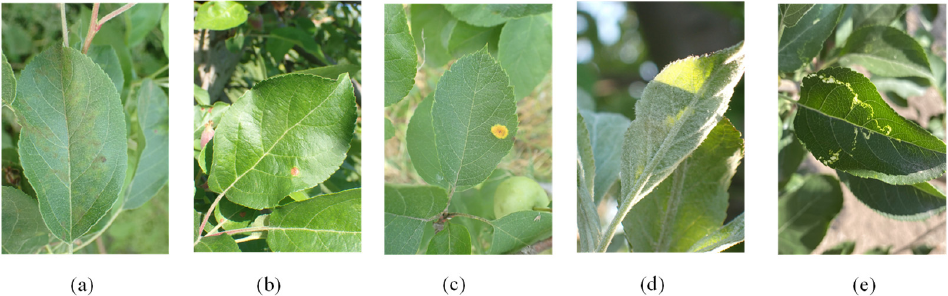
Figure 1. Image samples and their scientific name. ( a ) Scab (Venturia inaequalis (Cooke) G. Winter). ( b ) Frogeye leaf spot (Alternaria alternata (Fr.) Keissl). ( c ) Rust (Gymnosporangium asiaticum Miyabe ex G. Yamada). ( d ) Powdery mildew (Podosphaera leucotricha (Ell. Ev Ev.) Salm.). ( e ) Mosaic (Apple mosaic virus).